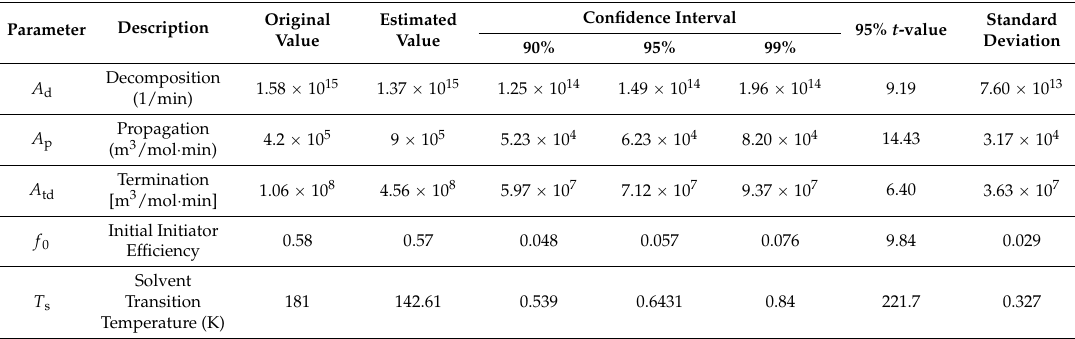
Table 2. Original and estimated value of the kinetic rate parameters for the free radical polymerization of MMA (first iteration).